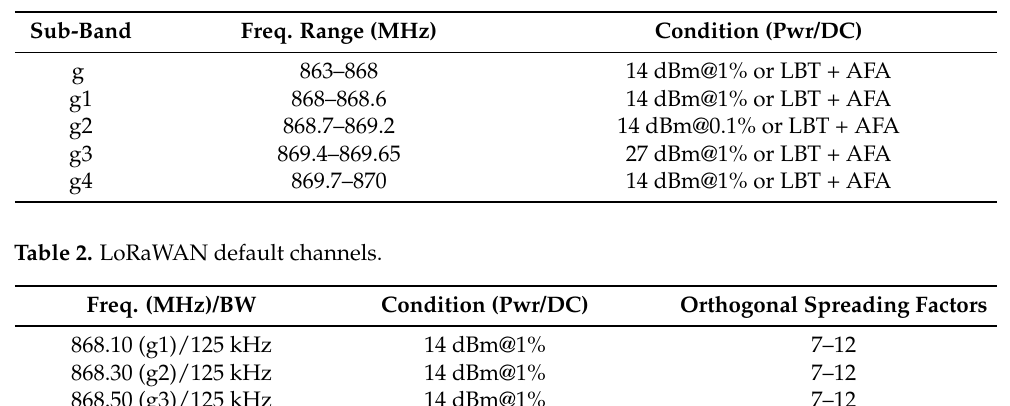
Table 1. Frequency plan sub-band g EU868-SEMTECH with MTP and DC.